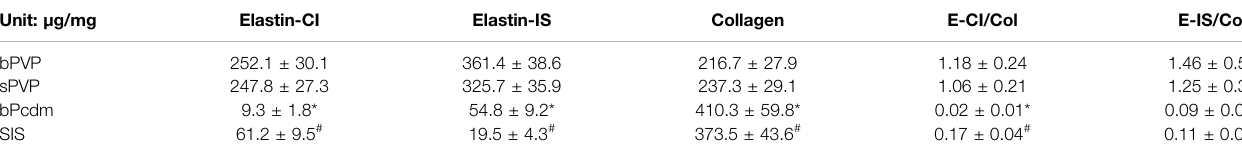
TABLE 2 | Dry weights of elastin and collagen in the tissues. Unit: μ